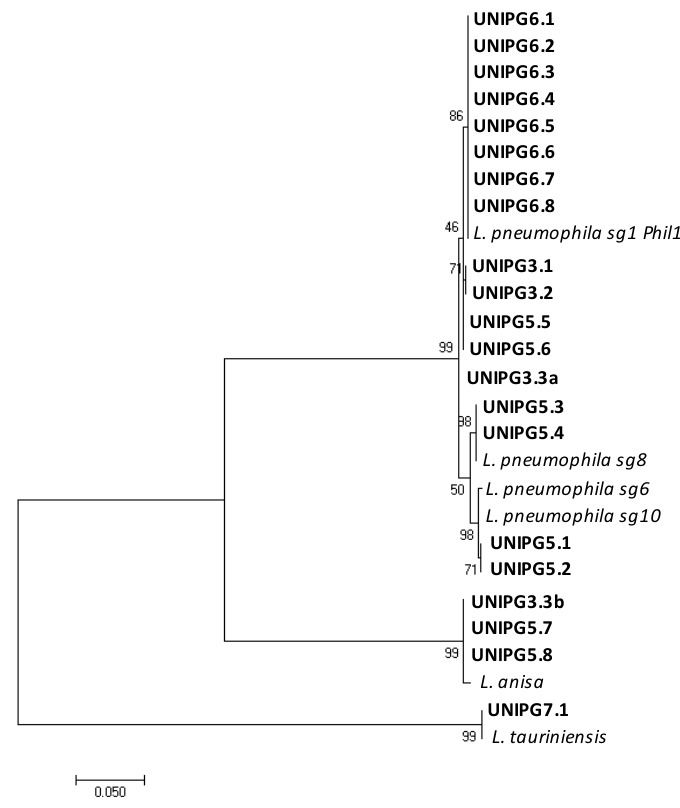
Figure 4. Maximum likelihood phylogenetic tree showing similarities between mip gene sequences of isolates found in this study (in bold) and those of closely related reference strains of Legionella retrieved in the GenBank database. Only one representative isolate for each group of identical sequences from the same control point is reported.